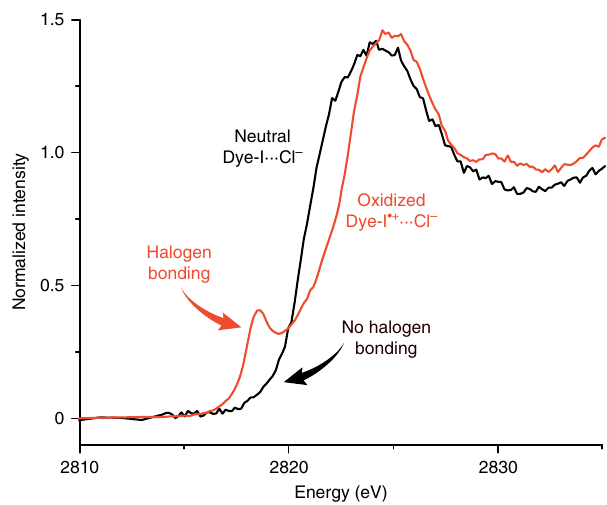
Fig. 3 XAS spectra of neutral and oxidized dyes in presence of chloride. Chlorine K-edge X-ray absorption spectroscopy (XAS) spectra recorded on TiO 2 substrates stained with Dye-I and Dye-I + in the presence of 100 mM acetonitrile solution of tetrabutylammonium chloride. The pre-edge feature at ca . 2818 eV is indicative of a halogen bonding interaction where charge is transferred from chloride to the σ *